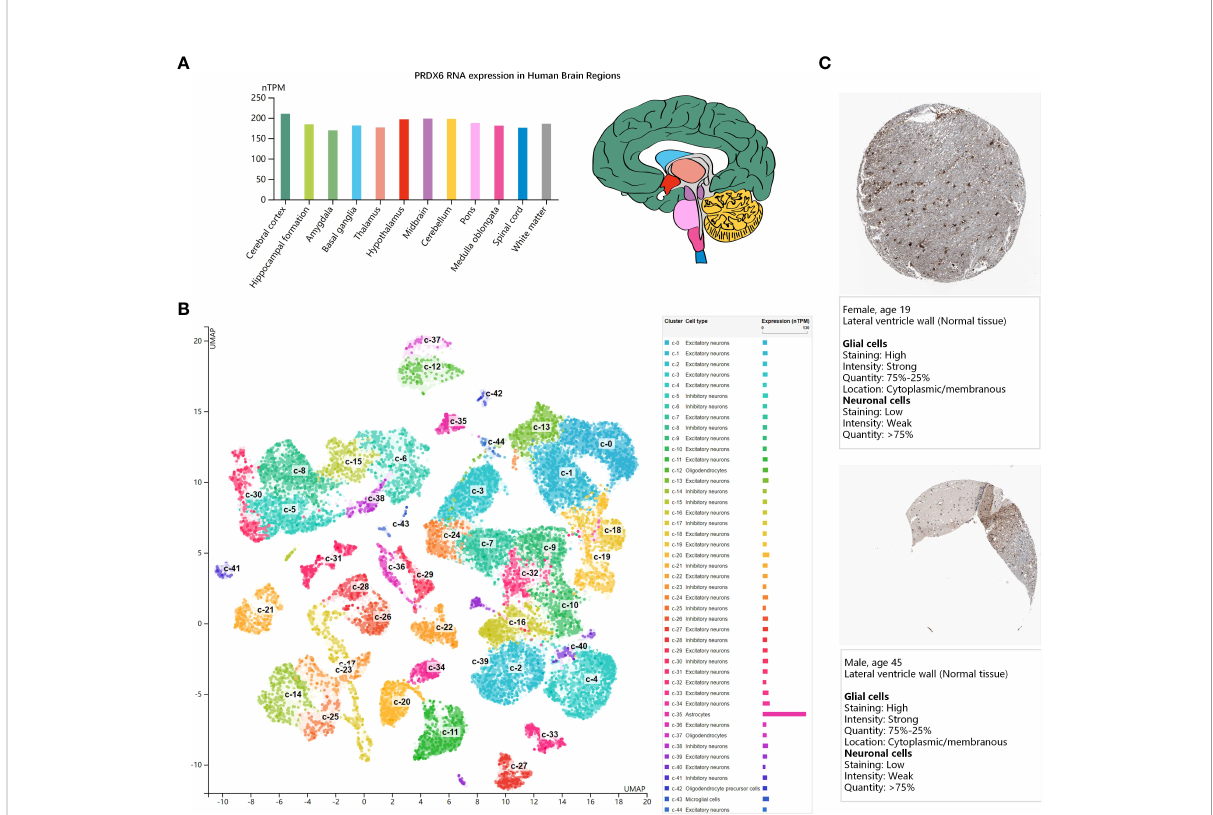
FIGURE 2 PRDX6 expression in human brain (the HPA database). (A) The bar-plot shows normalized RNA expression levels of PRDX6 in the 13 human brain regions. Color coding is based on brain region and the bar shows the highest expression among the subregions included. The bar-plot in red shows the distribution of PRDX6 mRNA expression in subregions of Hypothalamus. (B) The UMAP plot shows mRNA expression of PRDX6 in the single cell type clusters identi fi ed in brain tissue, and each dot corresponds to a cell. The bar-plot shows the mRNA expression levels of PRDX6 in each cell type cluster. The unique color assigns to each cluster. (C) The immunohistochemistry results of PRDX6 in histological sections from normal human brain tissues. nTPM, normalized transcript per